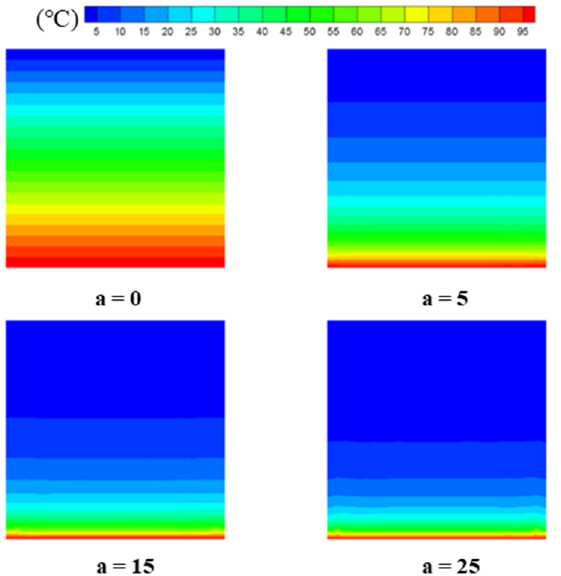
Figure 9. Temperature distribution in the FGM plate with different gradient coefficients.